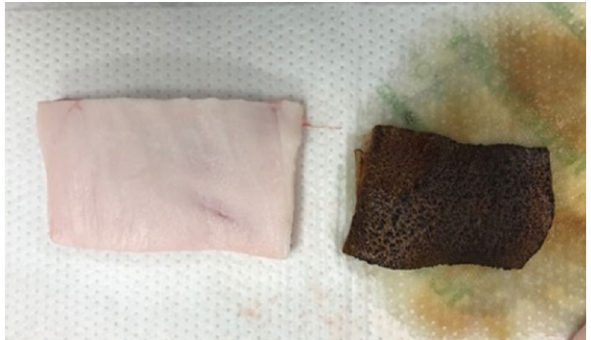
Figure 2. An example of uncharred and charred adipose tissue. Approximate size measuring 8 cm × 4 cm for the uncharred adipose tissue, 6 cm × 3.5 cm for the charred adipose